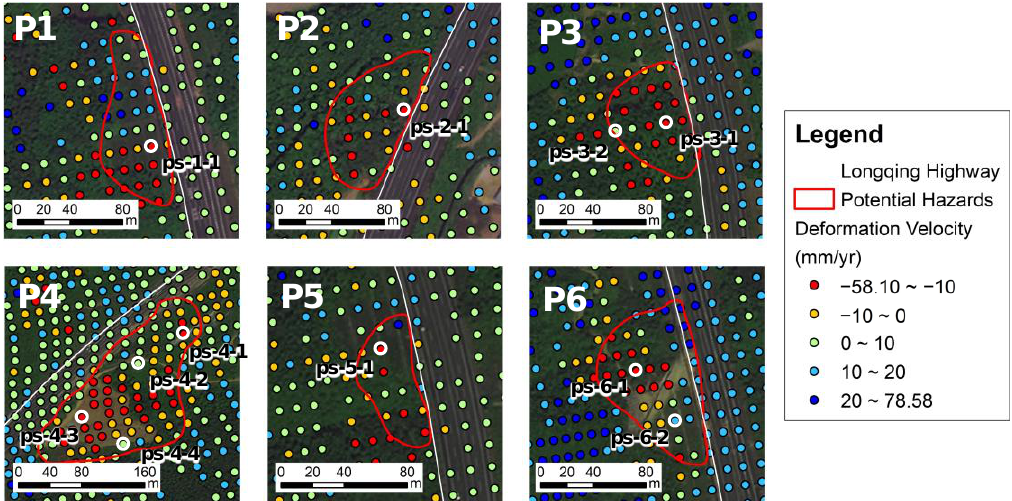
Figure 8. Average deformation velocity map for the identified potential hazards.